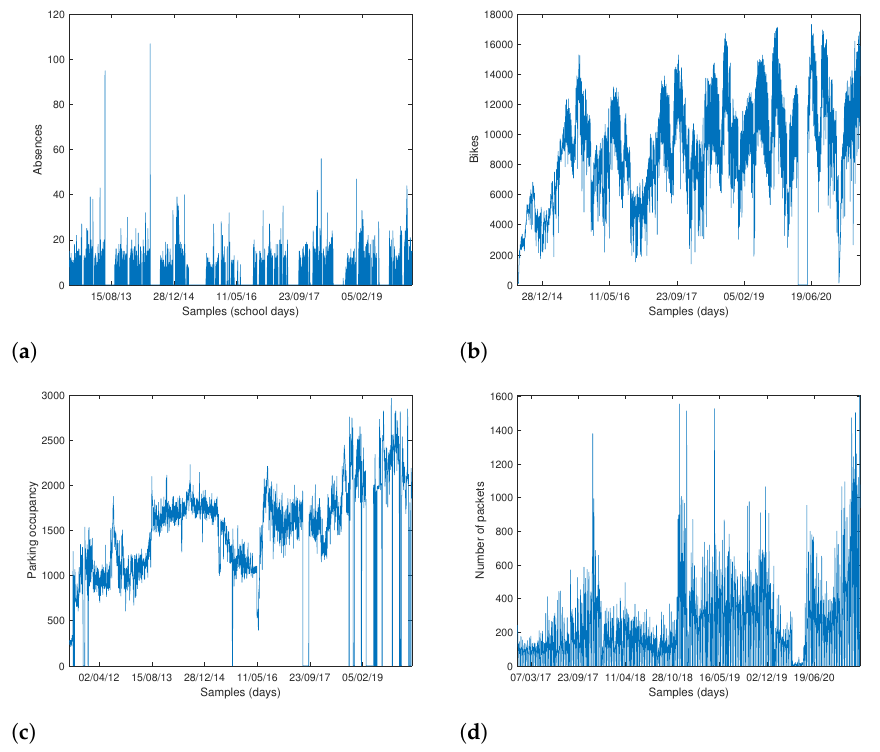
Figure 1. Time series with human-activity patterns considered in this work. ( a ) School absences time series. ( b ) BiciMad time series. ( c ) Parking occupancy time series. ( d ) Packets delivery time series.